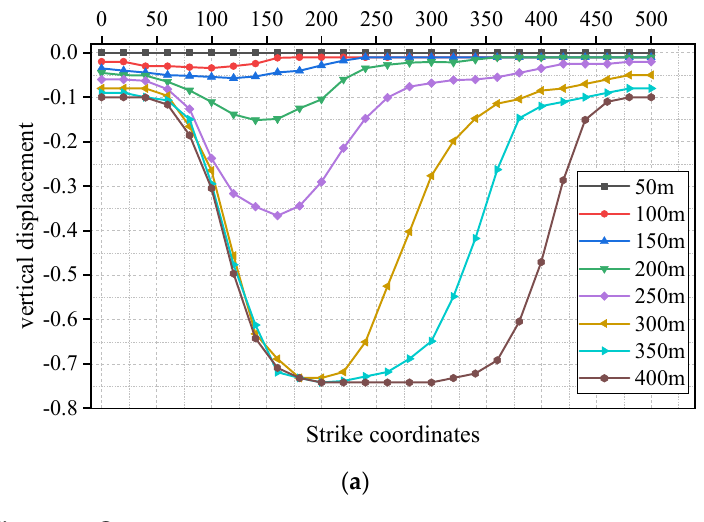
( b ) ( c ) Figure 13. Curve of surface subsidence with the advance of working face. ( a ) Observation line A . ( b ) Observation line B . ( c ) Observation line C. 5. Discussion Based on the numerical simulation and theory analysis, the maximum surface sub- sidence of the mining area for the karst aquifer without water drainage was 0.62 m and 0.6 m, respectively, and the maximum surface subsidence of the mining area with consid- ering water drainage was 0.72 m and 0.73 m, respectively, which was consistent with the field monitoring result of 0.74 m. It verified the results and the accuracy of the numerical simulation and theoretical calculation. The proposed theory model in this study was